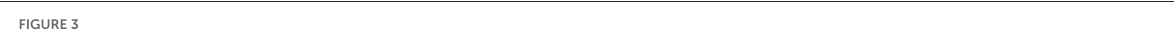
FIGURE3 72h after addition of the inhibitors. (B) Virus titer upon the addition of combinations of the DAAs daclatasvir and sofosbuvir (concentrations in the cell culture medium given in the boxes) either at the time of infection or 72h post-infection (indicated in abscissa); infections were carried out in parallel with HCV p0 and HCV p200. (C) Same as (B) except that the inhibitors used were combinations of the mutagenic nucleoside analogs favipiravir and ribavirin. For B and C, the statistical significance of the differences between values given in the bars are given as